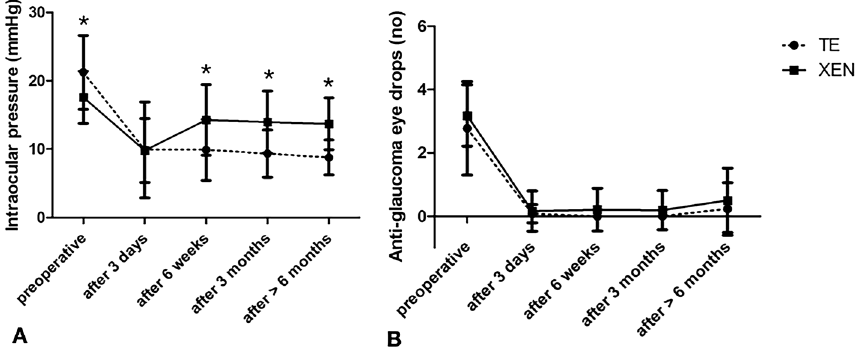
Figure 3. Change in ( A ) intraocular pressure (in mmHg) and ( B ) number of anti-glaucoma eye drops for the follow-up intervals. *marked significant differences between both treatment groups.